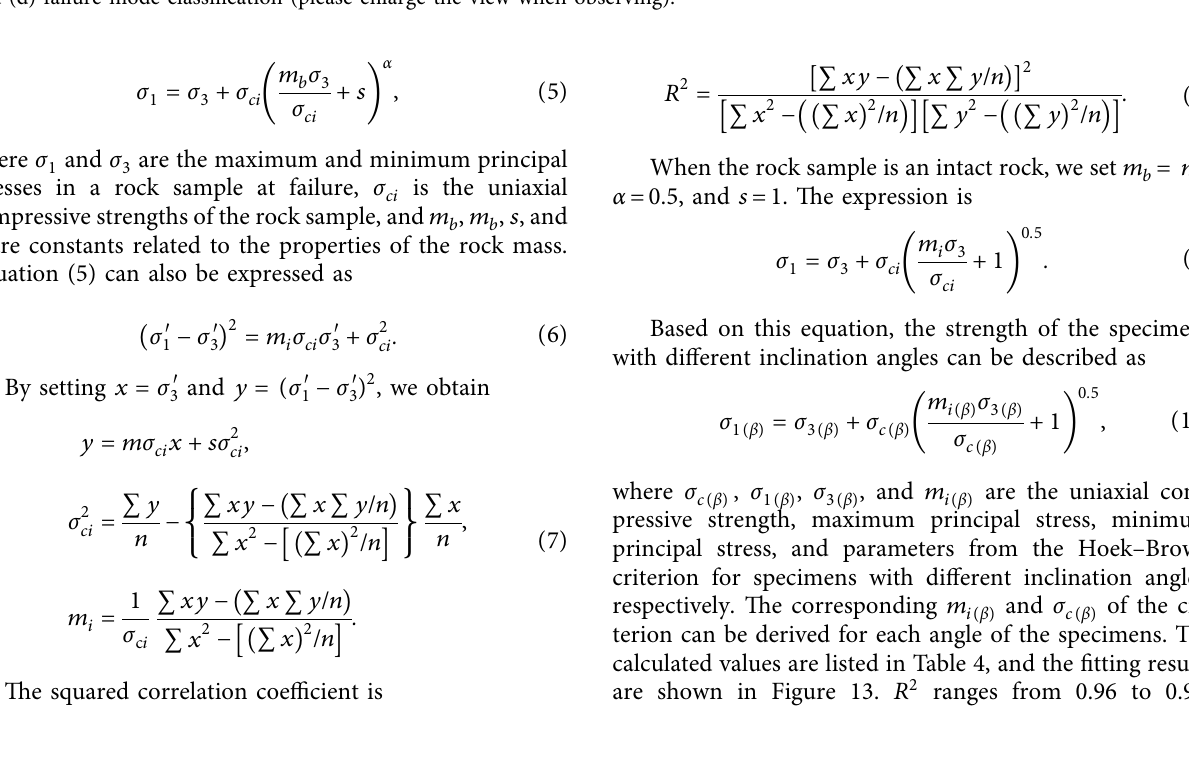
Figure 11: Failure modes of the composite layered samples under different confining pressures. (a) Group AA, (b) Group AB, (c) Group AC, and (d) failure mode classification (please enlarge the view when